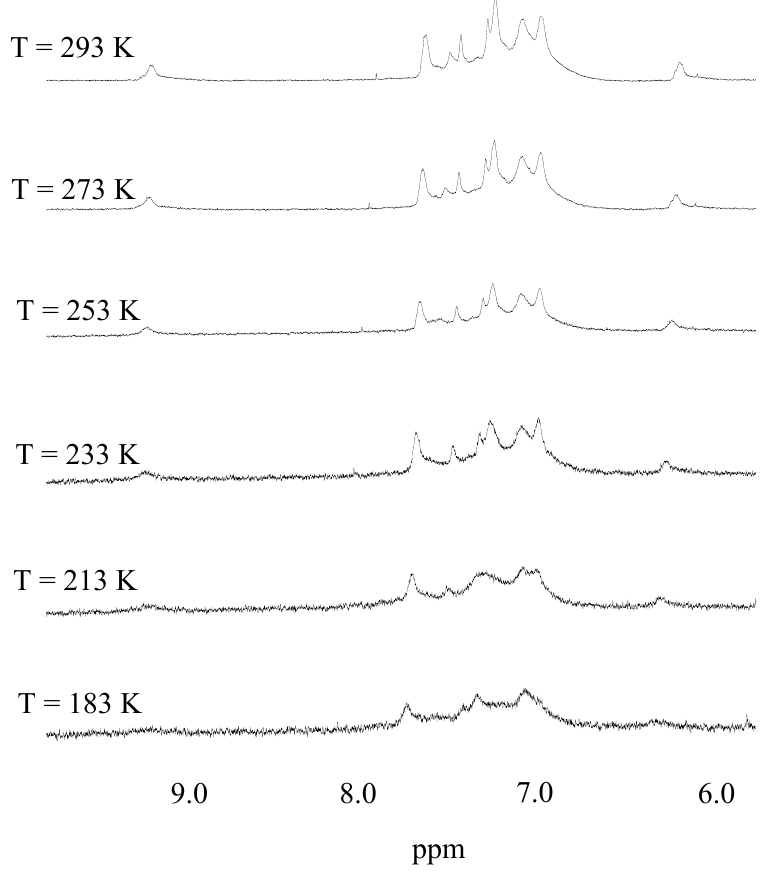
Figure 3. Variable temperature 1 H NMR spectrum of 6-UO (CD ) CO) at relevant 3 2